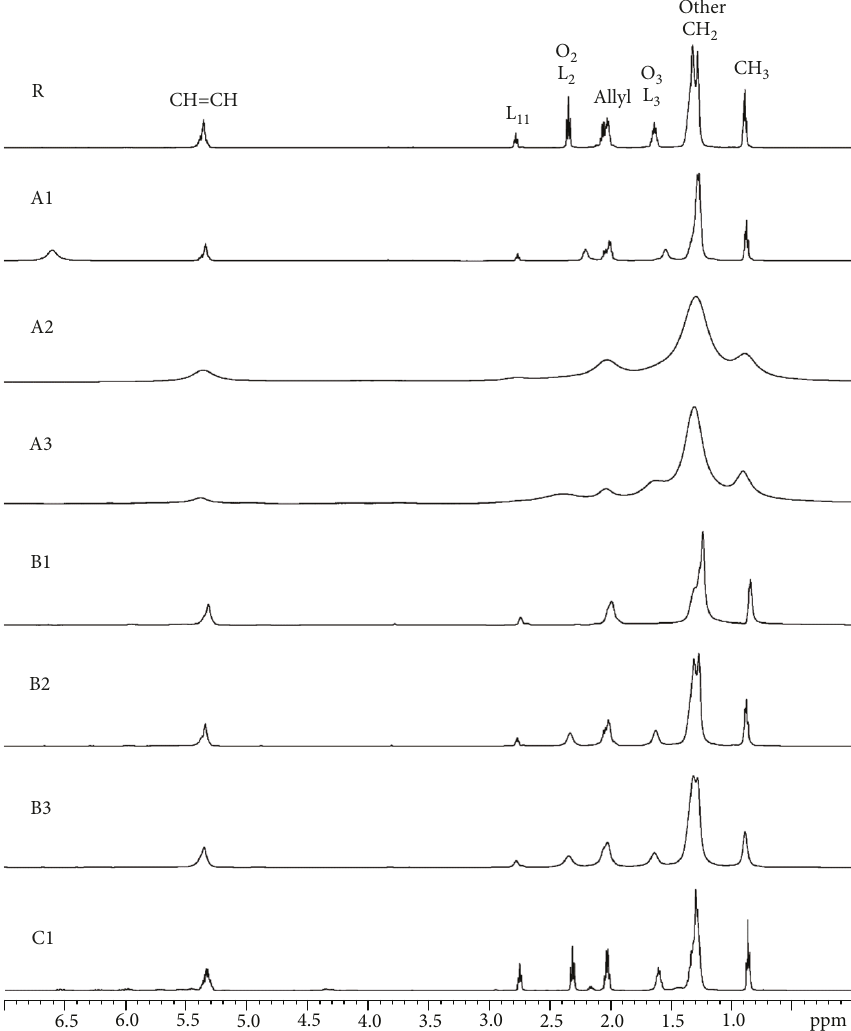
Figure 3: 1 H NMR spectra of the products obtained from a fatty acid/iron/carbon dioxide/water